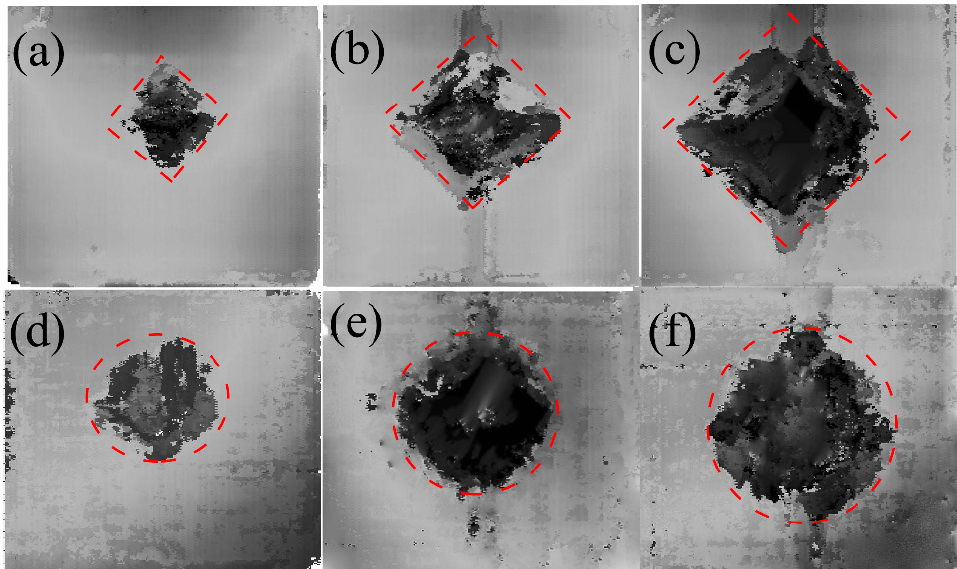
Figure 9. C-scan characteristic of the specimen after the impact velocities of ( a ) 45 m/s, ( b ) 68 m/s, and ( c ) 86 m/s in “dry” and of ( d ) 45 m/s, ( e ) 68 m/s, and ( f ) 86 m/s in “wet” for the flat-ended projectile.